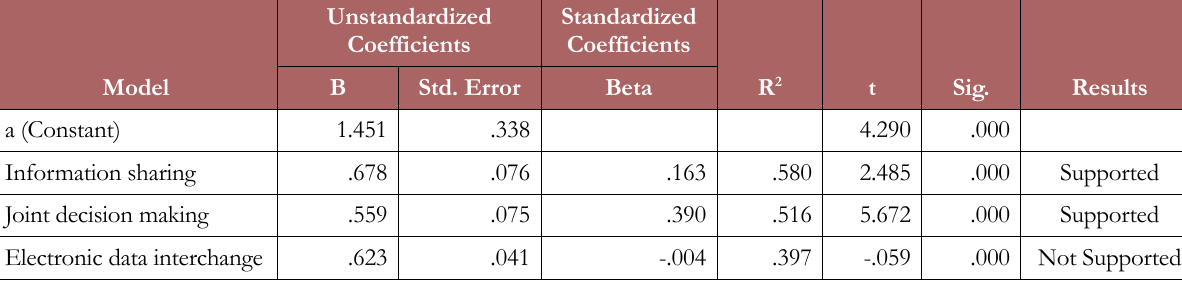
Table 4. Regression